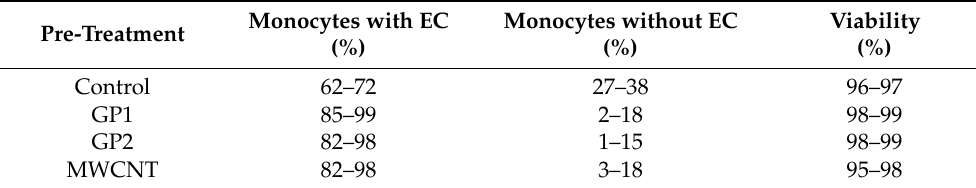
Table 2. Percentage of monocytes that phagocytosed EC after 3 h of exposure as measured by flow